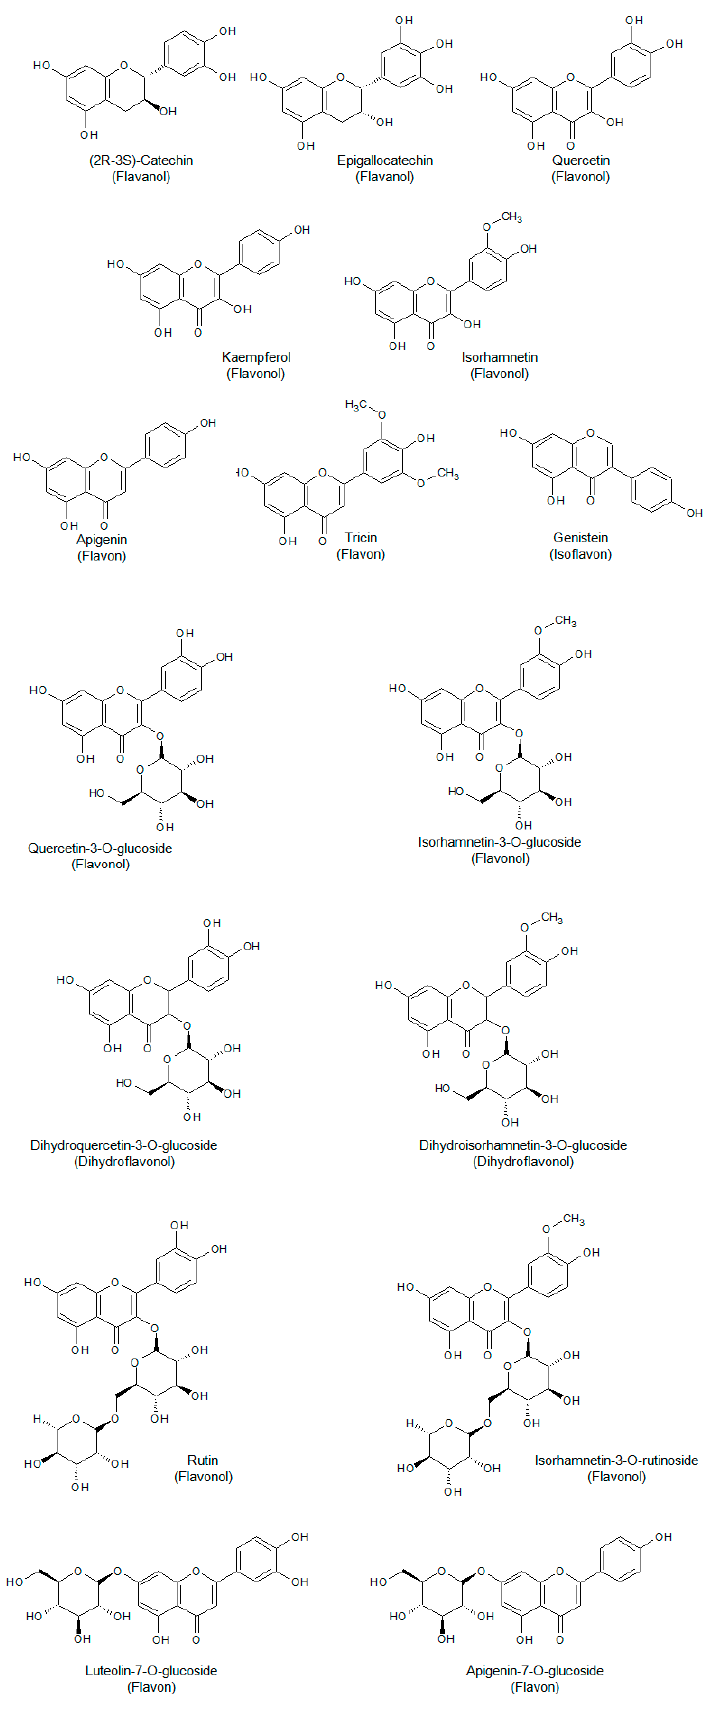
Figure 2. Some flavonoids commonly found in rice.